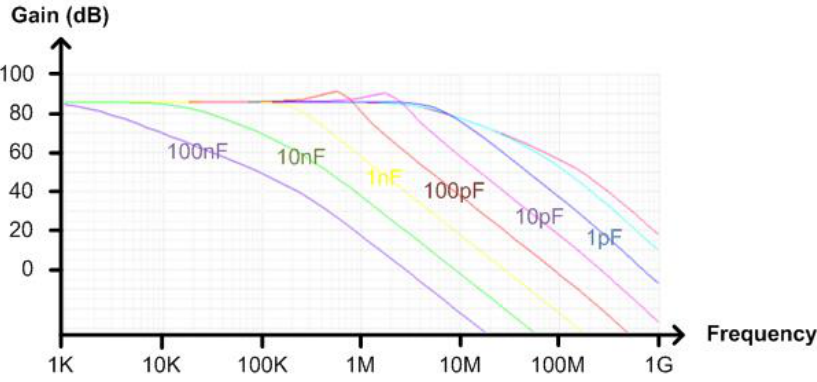
Figure 11. Simulated gain of the TIA versus C L .